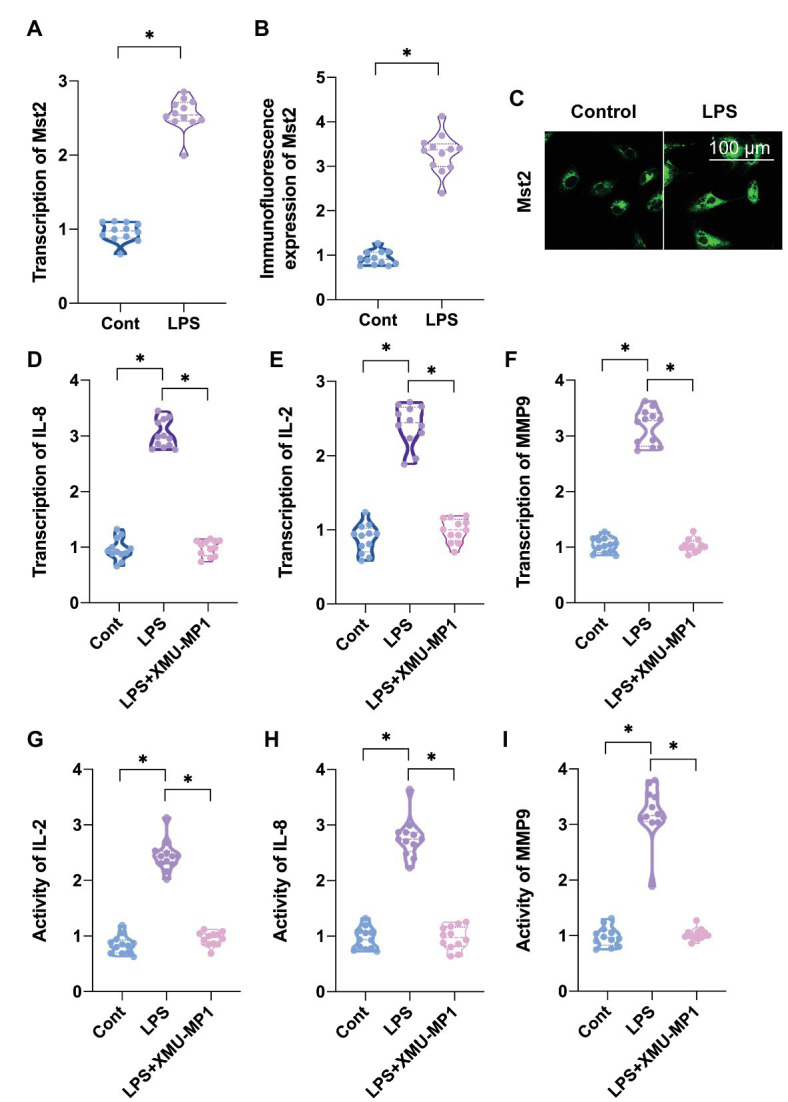
Mammalian STE20-like protein kinase 2 (Mst2) regulates inflammation in Lipopolysaccharides (LPS)-treated H9C2 cardiomyocytes. (A) Quantitative Real Time PCR (QRT-PCR) analysis shows Mst2 mRNA levels in the control and LPS-treated H9C2 cells. H9C2 cardiomyocytes were treated with LPS for 24 h. (B,C) Representative immunofluorescence images and quantitative analysis of Mst2 protein levels in the control and LPS-treated H9C2 cells. (D–F) QRT-PCR analysis shows IL-2, IL-8, and MMP9 mRNA levels in control, LPS-treated, and XMU-MP1 plus LPS-treated H9C2 cardiomyoctes. (G–I) ELISA assay results show IL-2, IL-8, and MMP9 levels in control, LPS-treated, and XMU-MP1 plus LPS-treated H9C2 cardiomyoctes. LPS treatment was performed for 24 h. H9C2 cells were pre-treated with the Mst2 blocker, XMU-MP1 for 6 h before treatment with LPS treatment. *
p < 0.05.